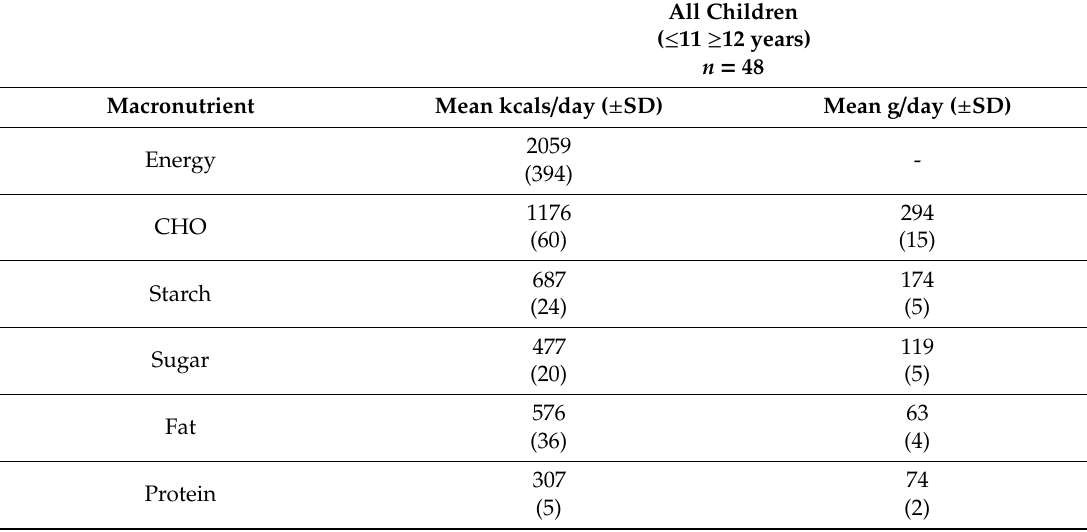
Table 2. Mean (standard deviation) contribution of calories and grams per day from carbohydrate (including starch and sugar), fat and protein to mean total energy intake for all children over the 3-year study